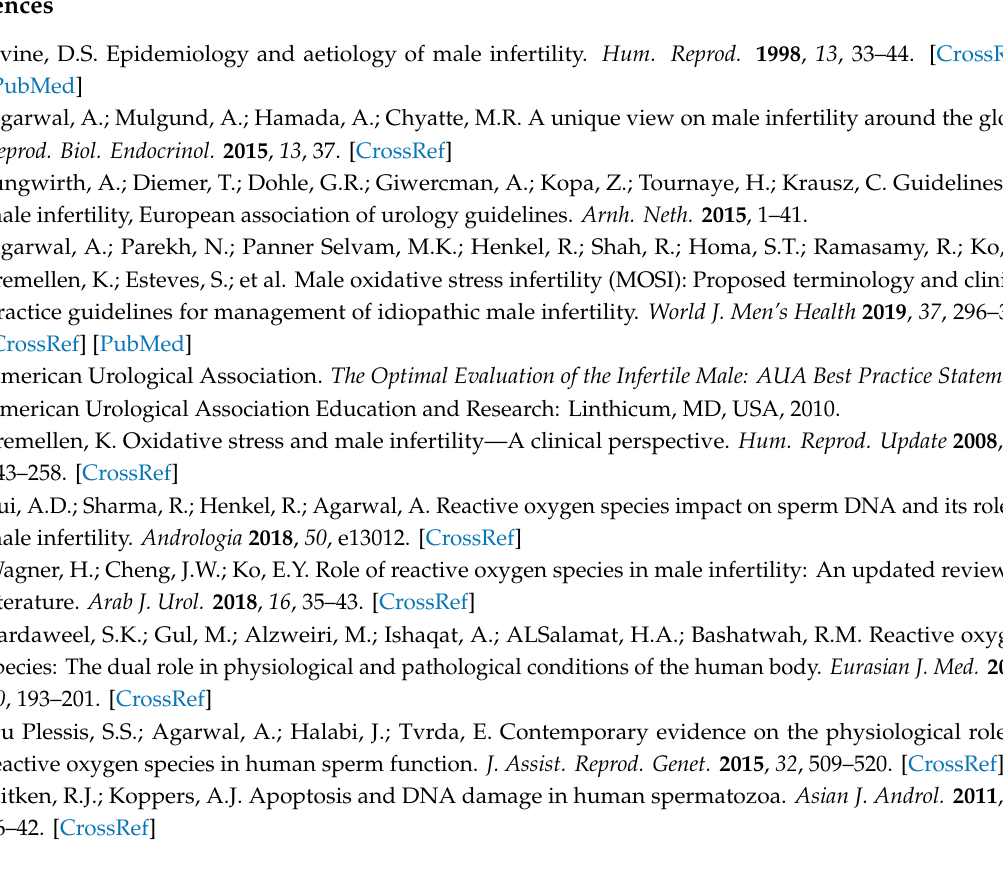
Table S1: Number and percentage of patients with oligozoospermia, asthenozoospermia and teratozoospermia before and after the treatment with FH PRO for Men. Total number of patients included in the study: n =